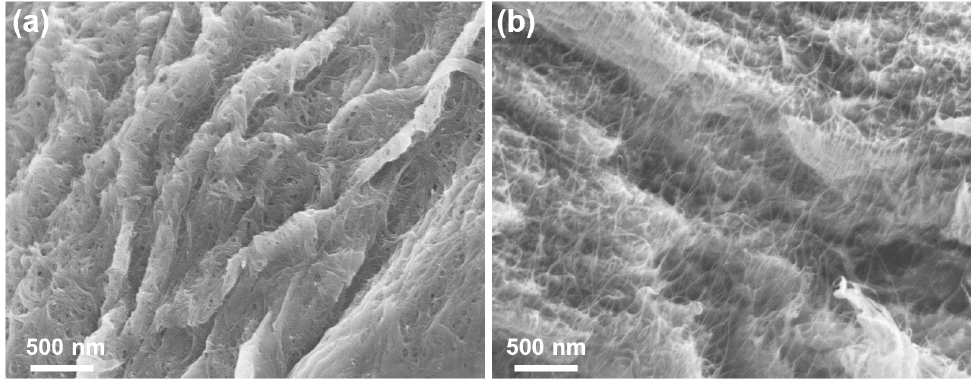
Figure 4. Scanning electron micrographs of the cross sections of ( a ) 0.25:1 paste film and ( b ) buckypa- per fabricated from